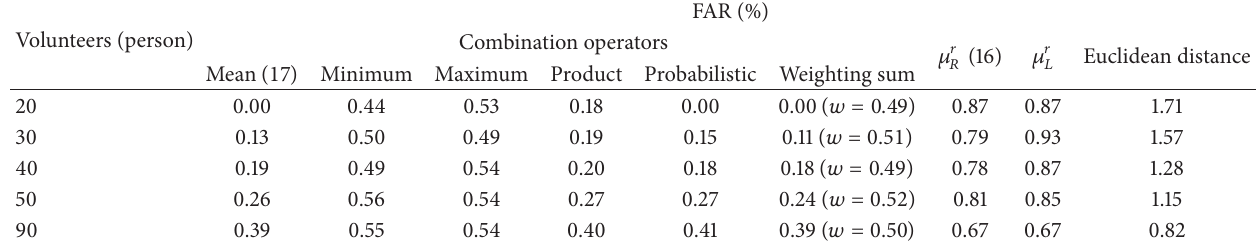
Table 5: FARs in identification of combination